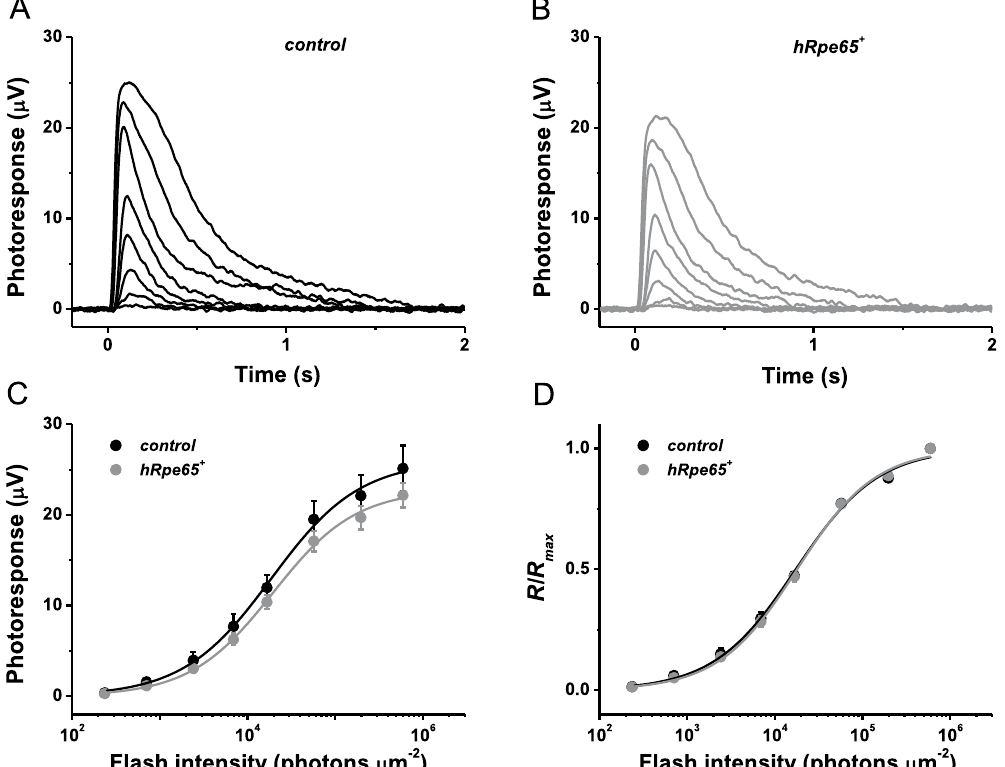
Figure 6. Transgenic expression of human RPE65 does not affect M-cone responses. ( A ) Representative family of ex vivo cone ERG responses from control Gnat1 − / − mouse retinas. Test flashes of 505 nm light with intensities of 235, 705, 2.4 × 10 3 , 7.0 × 10 3 , 1.7 × 10 4 , 5.7 × 10 4 , 2.0 × 10 5 , and 6.0 × 10 5 photons μ m − 2 were delivered at time 0. ( B ) Representative family of ex vivo cone ERG responses from transgenic Gnat1 − / − hRpe65 + mouse retinas. Test flashes of 505 nm light with the same intensities as in ( A ) were delivered at time 0. ( C ) Averaged cone intensity-response functions (mean ± SEM, not statistically significant at any light intensity) for control Gnat1 − / − (n = 6) and transgenic Gnat1 − / − hRpe65 + (n = 6) mice. Hyperbolic Naka-Rushton fits yielded half-saturating intensities ( I 1/2 ) of 1.9 × 10 4 and 2.0 × 10 4 photons μ m − 2 for control and transgenic animals, respectively. ( D ) Normalized averaged cone intensity-response relationships (mean ± SEM, no statistical significance at any light intensity) for control Gnat1 − / − (n = 6) and transgenic Gnat1 − / − hRpe65 + (n = 6) mice. The data were fitted with Naka-Rushton equations that yielded I 1/2 -values as in ( C ). Error bars for some points in ( C , D ) are smaller than the symbol